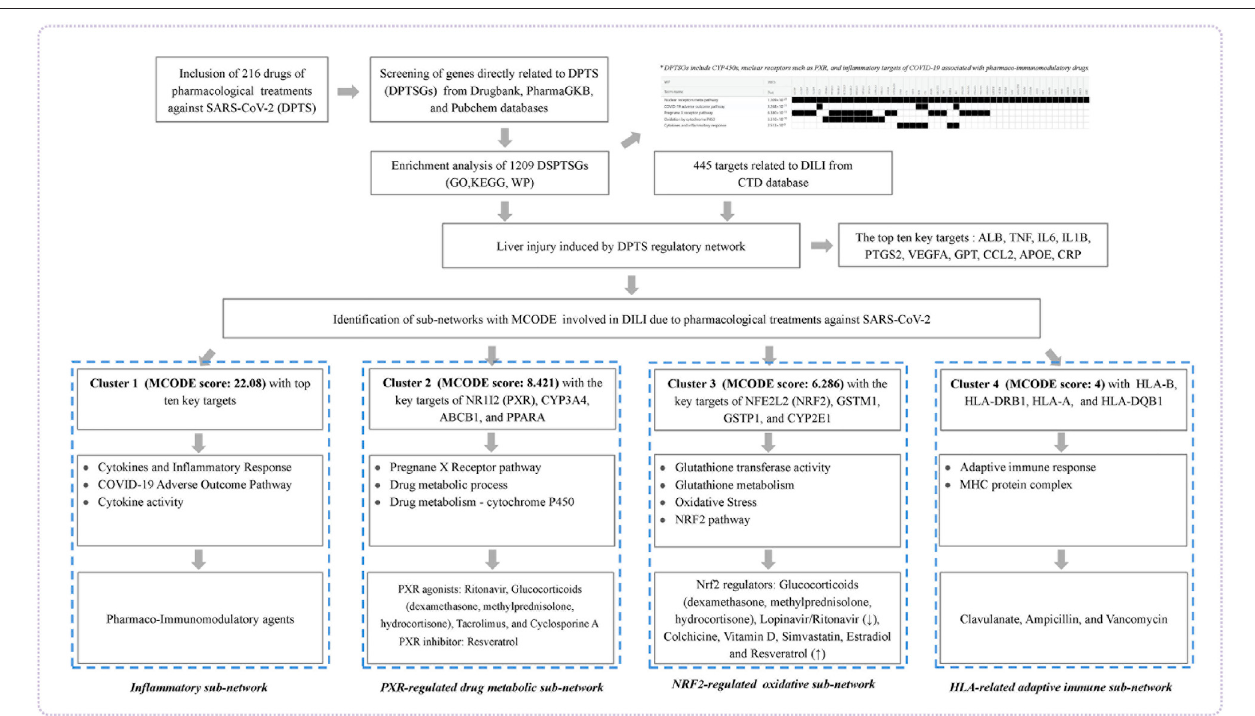
FIGURE 1 | Work fl ow of the present study. The fi gure indicated the mechanism underlying liver injury induced by DPTS using bioinformatics and system biology analyses.